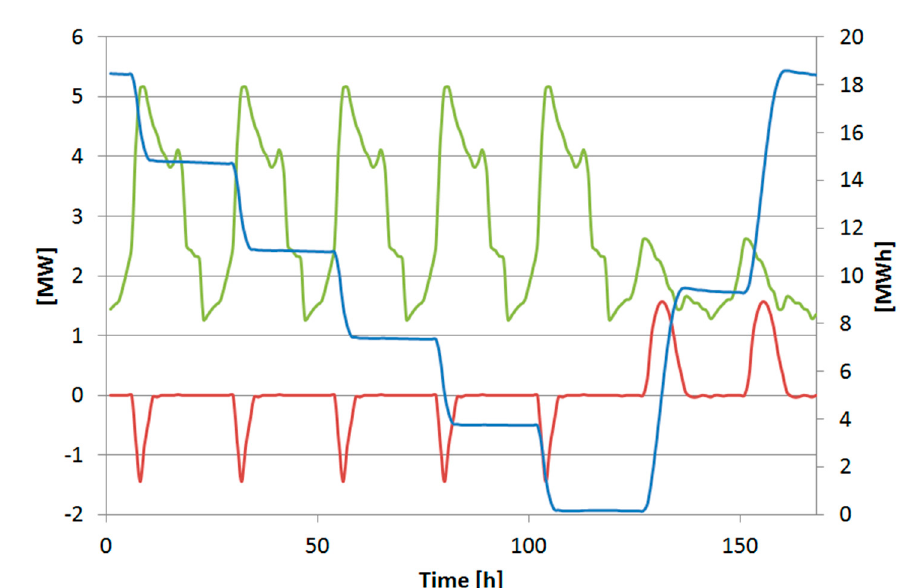
Figure 12. Optimal operation of the storage in a typical week-economic optimization of the distributed generation solutions integrated with the central solar system. Table 13. Total economic and environmental results of the optimizations—distributed generation solutions integrated with central solar unit.